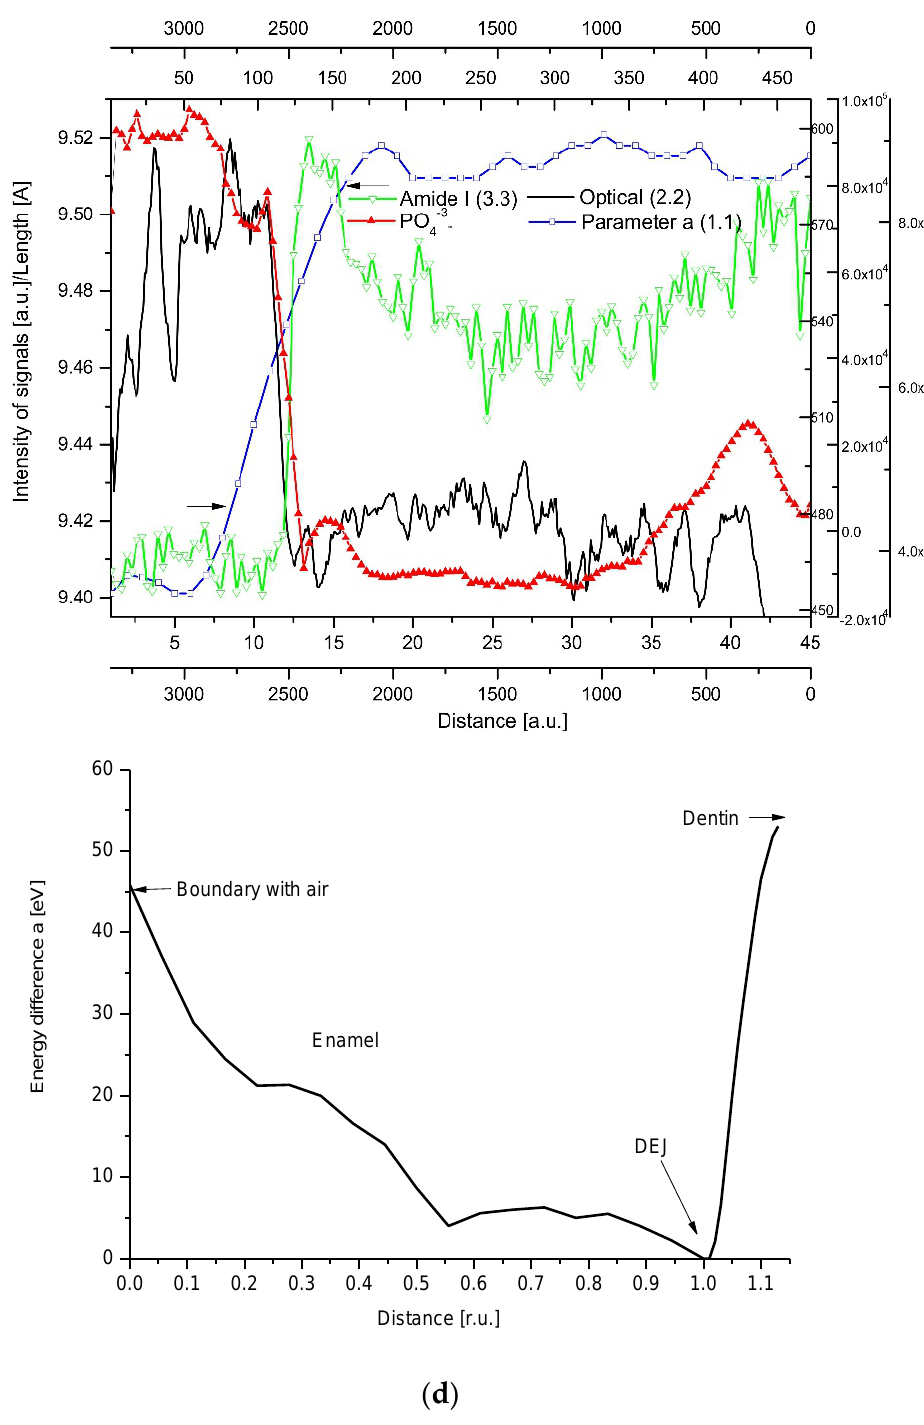
Figure 6. ( a ) Variability of crystallographic “a” parameter inside the tooth. ( b ) Generally faint variability of “c” parameter, even bearing in mind individual jumps. ( c ) Superposition of variability of parameter “a” on optical and chemical outline of the DEJ. Arrows show how the profile of “a” would be narrowed in the case of a better spatial resolution of the XRD system. ( d ) Energetic profile of whole enamel, DEJ, and fragment of dentin.